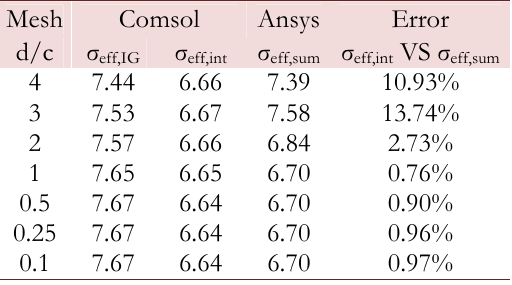
Table 4: Error occurs in the mesh